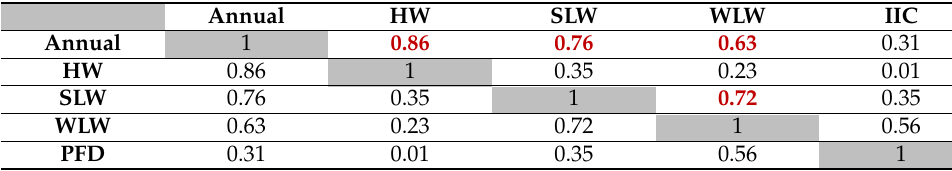
Table 5. The correlation coefficients—KR.